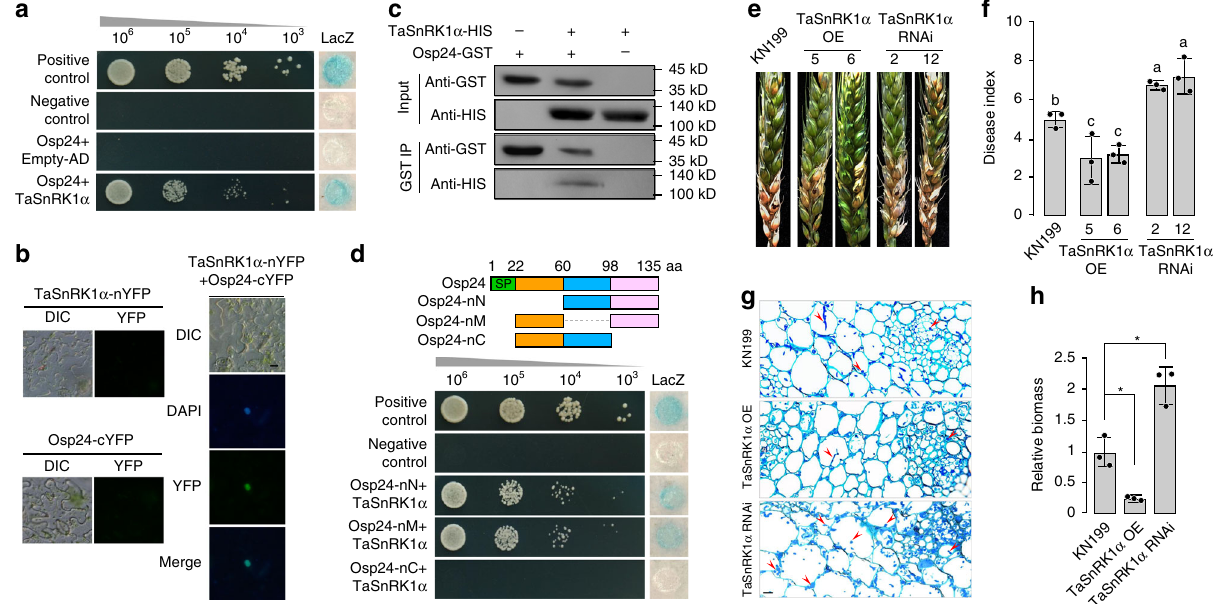
Fig. 3 Interaction of Osp24 with TaSnRK1 α and function of TaSnRK1 α in wheat resistance against F. graminearum . a Yeast two-hybrid assays to detect the interaction of Osp24 (Bait) with TaSnRK1 α (Prey). Different concentrations of the labeled yeast transformants were assayed for growth on SD-Trp-Leu- His plates and LacZ activity. b BiFC assays for the interaction of Osp24 with TaSnRK1 α . Leaves of N. benthamiana were agroin fi ltrated with a mixture of A. tumefaciens strains expressing the Osp24-nYFP and TaSnRK1 α -cYFP constructs. YFP signals were observed at 2 days post ‐ agroin fi ltration. In fi ltration with Agrobacterium expressing the TaSnRK1 α or Osp24 construct alone was used as the negative control. No YFP signals was observed in these negative controls. Scale bar, 20 µ m. c Veri fi cation of the Osp24 – TaSnRK1 α interaction by GST pull down assays. Western blots of the marked protein mixtures (Input) or proteins co-puri fi ed with TaSnRK1 α -HIS from these mixtures (GST IP) were detected with the anti-HIS and anti-GST antibodies. d Yeast transformants expressing the TaSnRK1 α (prey) and marked full-length or truncated Osp24 (bait) were assayed for growth on SD-Trp-Leu-His plates and LacZ activities. SP signal peptide. e Representative wheat heads of cultivar KN199 and its transgenic lines expressing the TaSnRK1 α overexpression (TaSnRK1 α OE 5 and 6) or silencing (TaSnRK1 α RNAi 2 and 12) construct were drop-inoculated with PH-1 and photographed at 7 dpi. f Mean and standard deviation (SD) of the disease index of PH-1 on the labeled wheat lines were estimated from three independent experiments ( n = 3) with at least 10 infected wheat heads in each experiment. Different letters indicate signi fi cant differences based on ANOVA analysis followed by Duncan ’ s multiple range test ( P = 0.05). g Thick sections of the rachises of wheat heads of KN199 and its TaSnRK1 α OE or TaSnRK1 α RNAi transgenic line inoculated with PH-1 were examined for invasive hyphae (red arrowheads) at 5 dpi. Scale bar, 50 µ m. h Relative biomass of F. graminearum was determined by qPCR in infected wheat heads of KN199 and labeled transgenic lines sampled at 5 dpi. Mean and standard deviation were estimated with data from three ( n = 3) independent biological replicates (indicated with black dots on the bar). *Indicates signi fi cant differences ( P = 0.05) based on Bootstrap